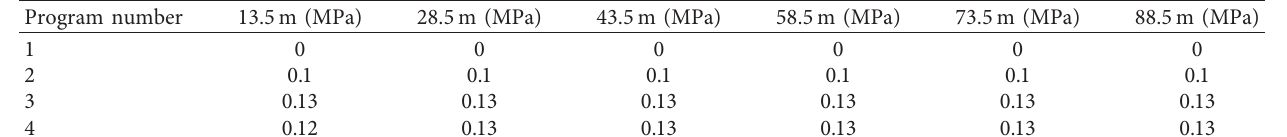
Table 7: Different grouting pressure program configuration of case A1.